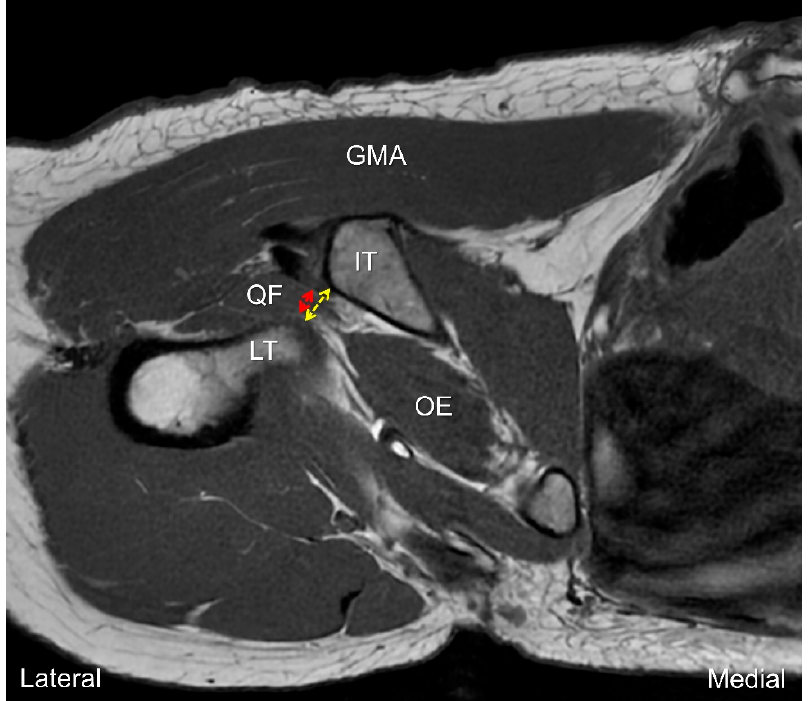
Figure 7. Axial T1 weighted MRI for measurement of the ischiofemoral (yellow dashed line) and quadratus femoris (red dashed line) spaces. GMA: gluteus maximus muscle; QF: quadratus femoris muscle; OE: obturator externus muscle; LT: lesser trochanter; IT: ischial tuberosity.